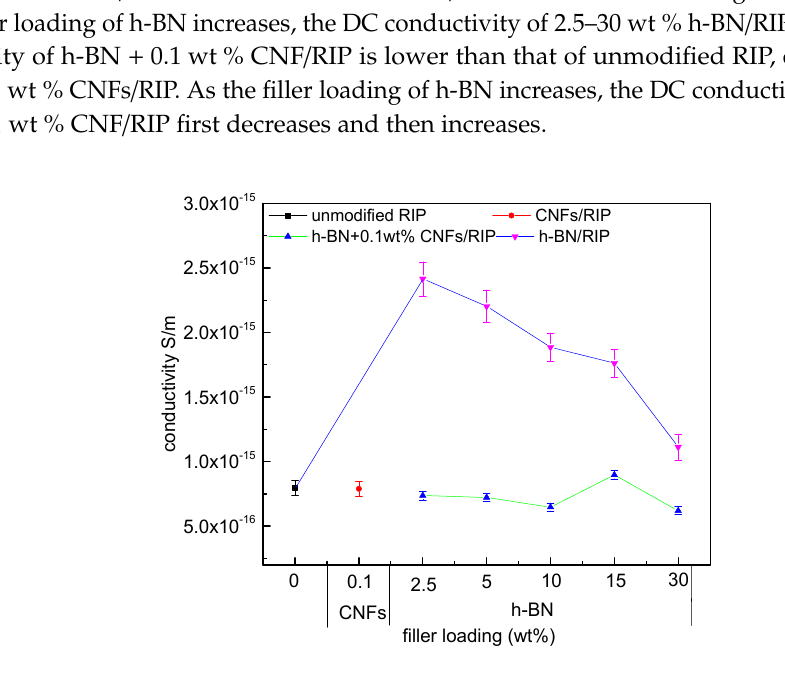
Figure 5. DC conductivity of unmodified RIP, CNF/RIP, h-BN/RIP, and h-BN/0.1 wt % CNF/RIP at 10 kV/mm.